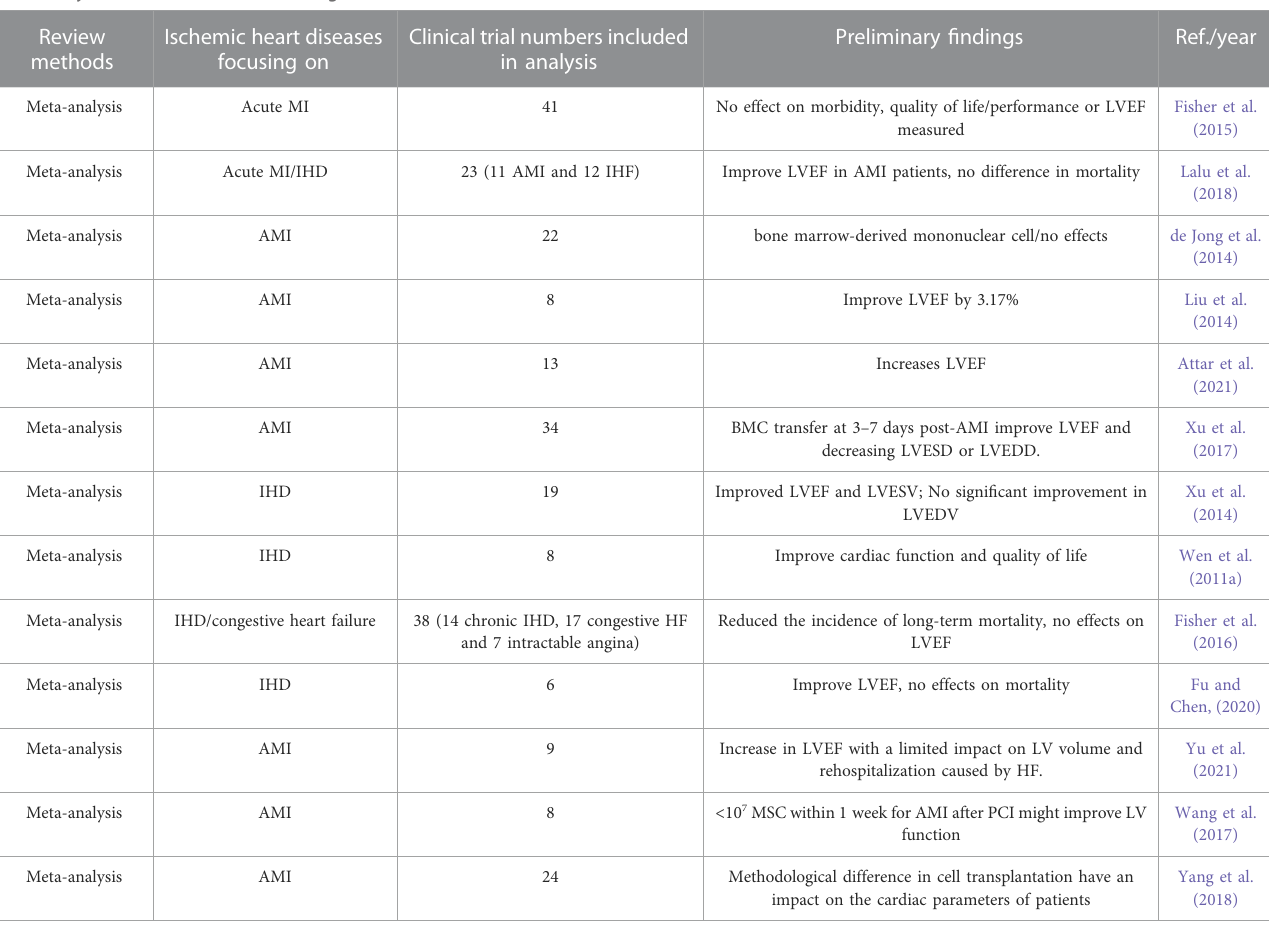
TABLE 1 Systematic clinical review of using BMMSC for ischemia heart disease